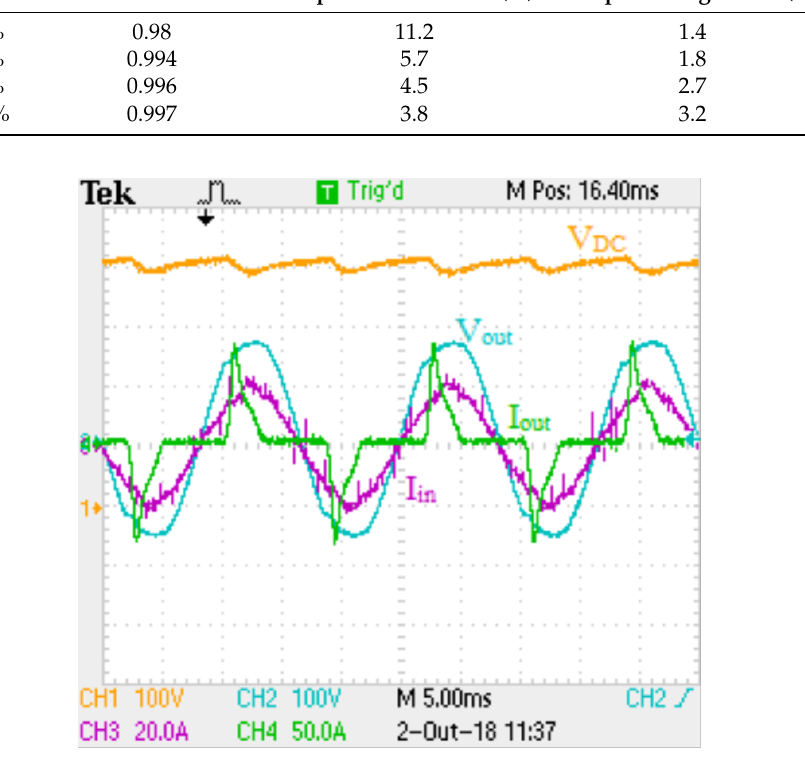
Figure 15. Experimental results supplying a nonlinear load. CH1: DC Link voltage, CH2: Output voltage, CH3: Input current, CH4: Output